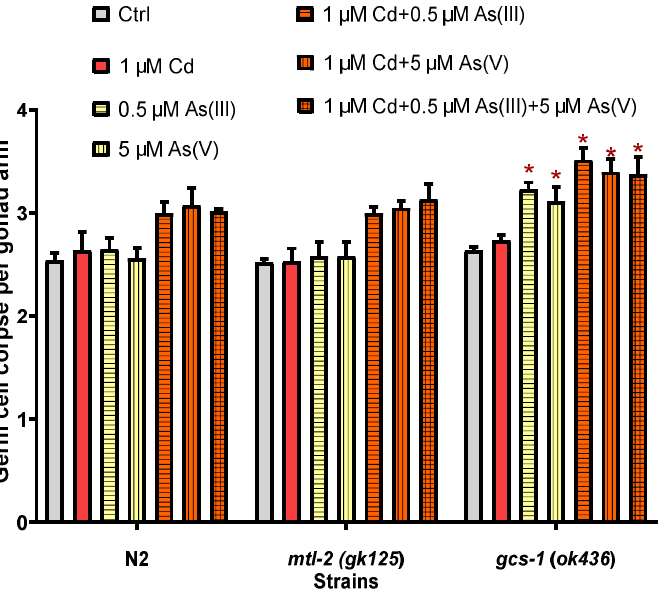
Figure 6. The effect of single and co-exposed Cd, As(III), and As(V) on apoptosis gonad cells of strains mtl-2 ( gk125 ) and gcs-1 ( ok436 ). * means compared with the corresponding groups of N2, p < 0.05.